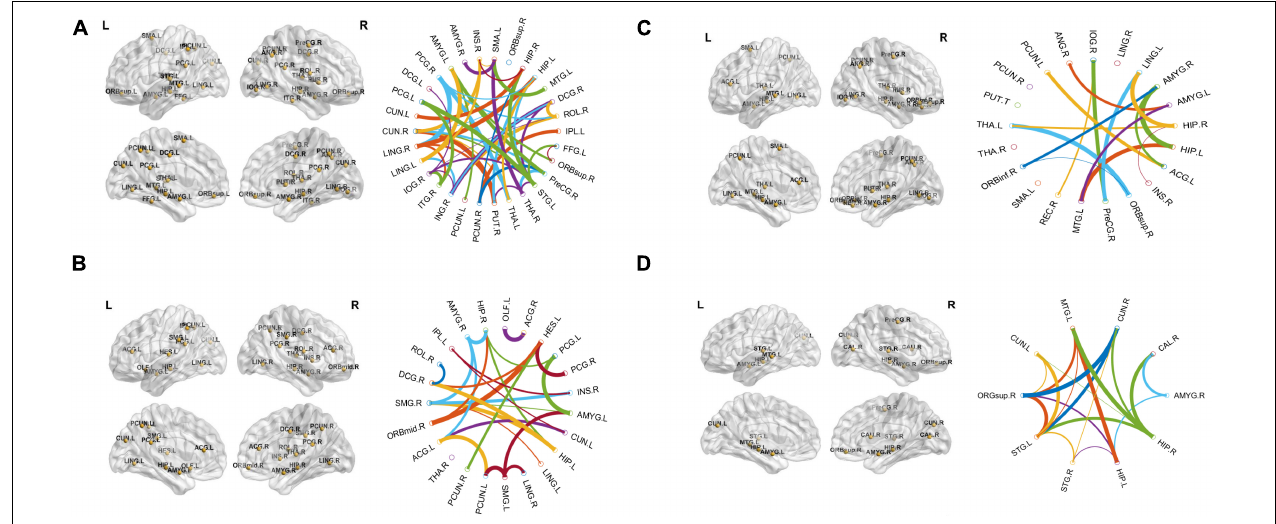
FIGURE 4 | The location and networks of cortical regions with the highly discriminative attribute of top brain regions (BrainNet Viewer) 8 and their corresponding circular connectivity (circularGraph) (http://www.mathworks.com/matlabcentral/fileexchange/48576-circulargraph): (A) Alzheimer’s disease (AD) vs. healthy control